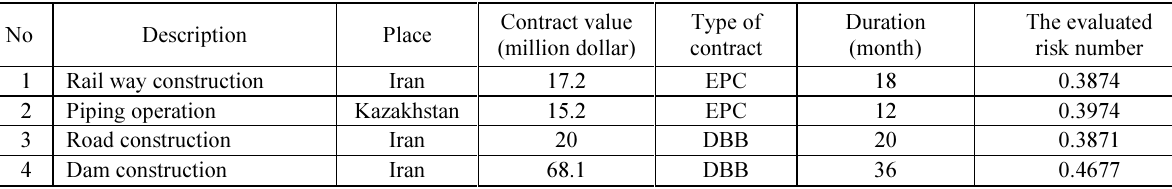
Table 5 . Specification and evaluated risk number of proposed projects